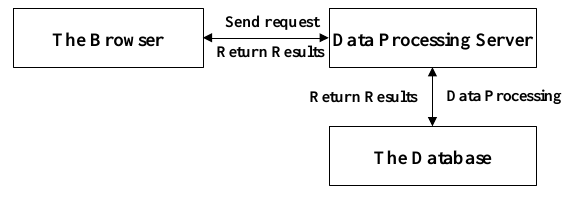
Figure 8 . Flow Chart of Complex 3D Analysis